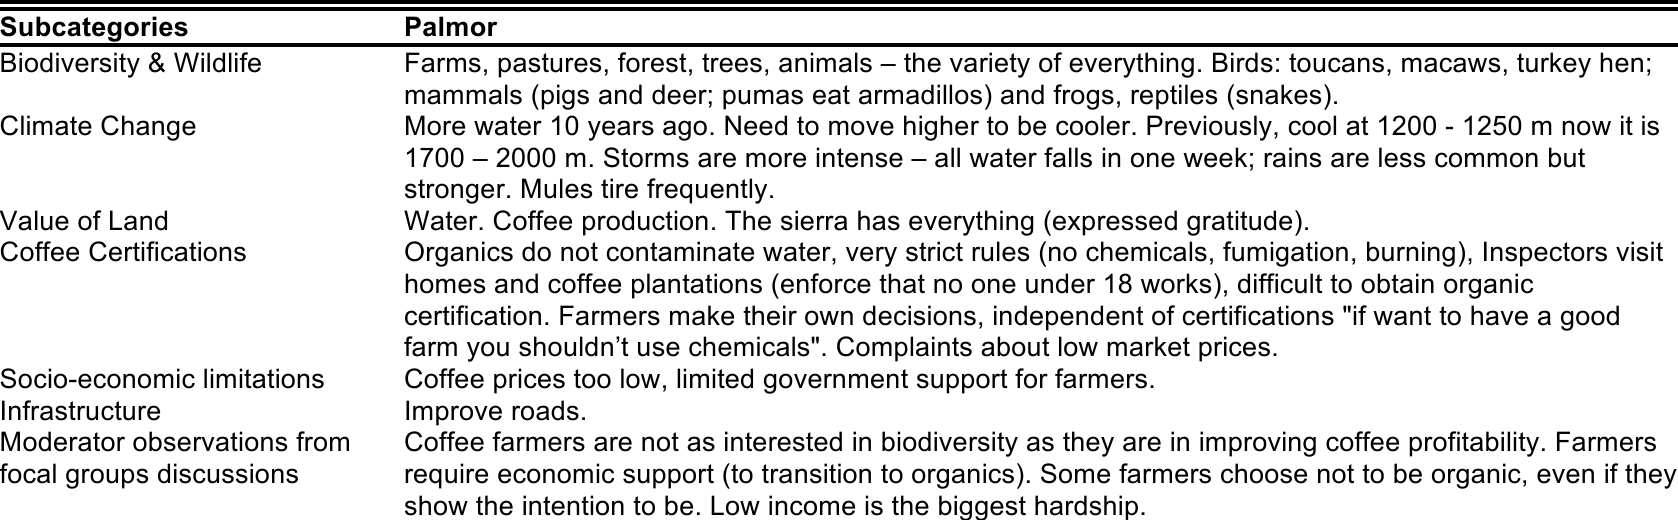
Ollas, San Javier, San Pedro, and Vista Nieve. Moderator observations from focus groups are included below in the final row. Table A2.1 The community of Palmor (n=16) presented